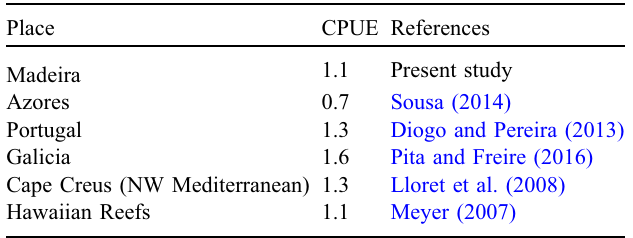
Table 4. Comparison of CPUE (kg/ fi sher/hour) values for spear- fi shing in Madeira and other regions of the